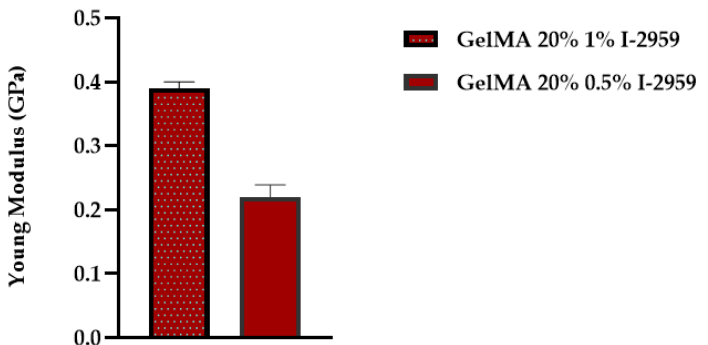
Figure 11. Modulus of GelMA with different concentrations of photoinitiator.